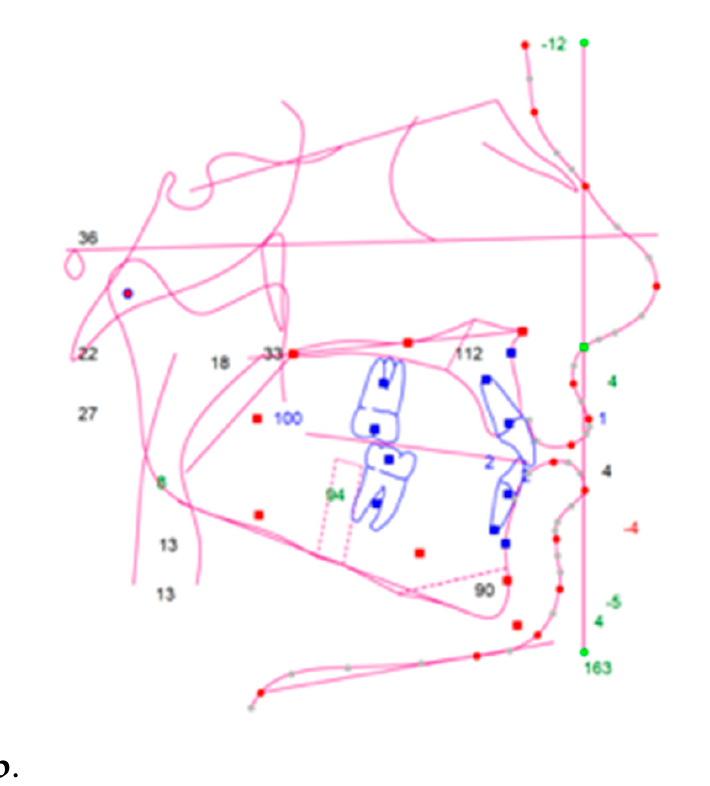
Figure 1. Cephalometric analysis before Intermolar mandibular distraction osteogenesis (IMDO) treatment. ( a ) Class II/1 occlusion. ( b ) Desired mandibular advancement distal to the first mandibular molar.